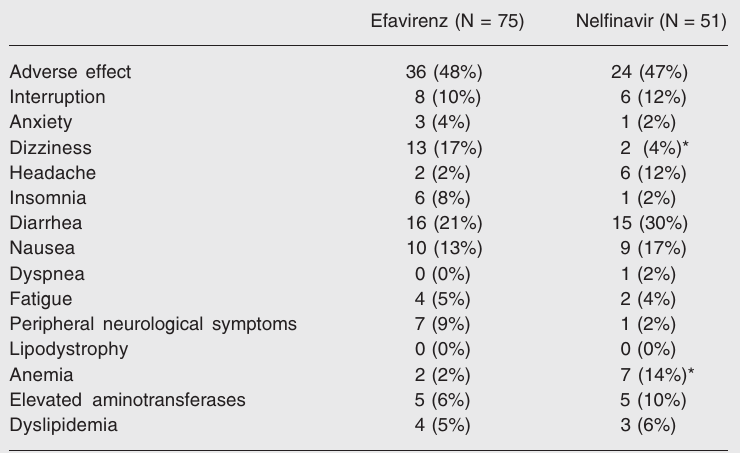
Table 2. Adverse effects observed in both groups of the antiretroviral